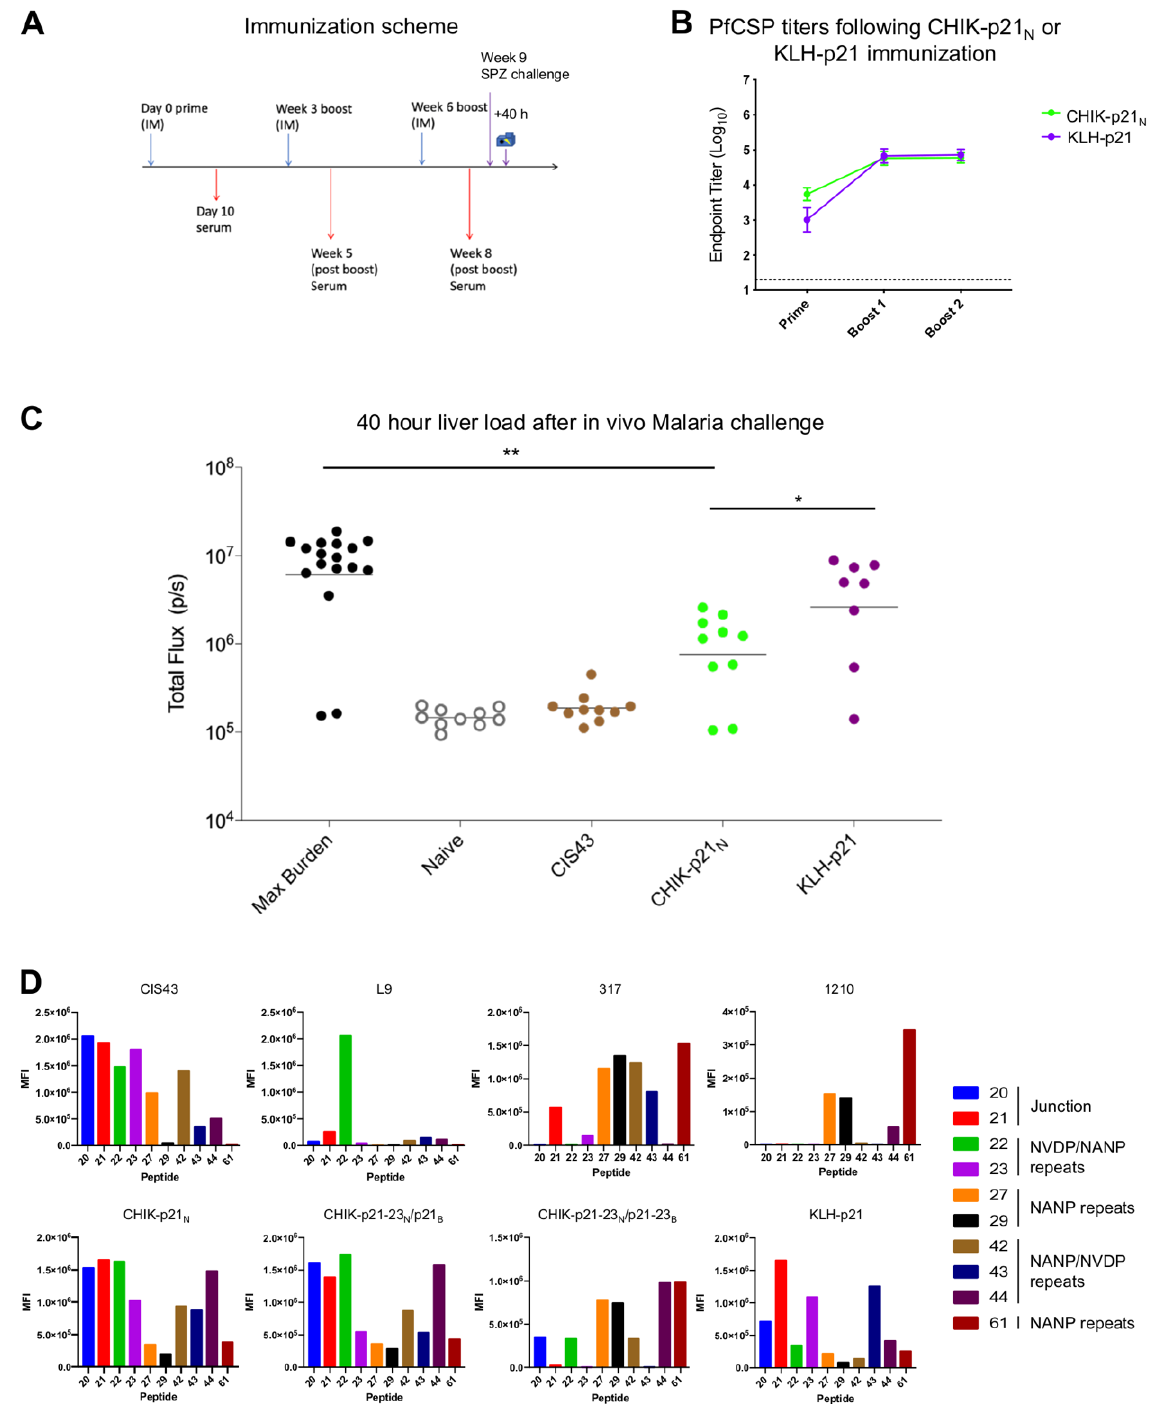
Figure 4. Comparison of malaria protection induced by CHIK-p21 and KLH-p21. ( A ) Immunization and challenge schema. Blue arrows denote immunizations and red arrows denote blood draws. Liver burden was quantified 40 h post challenge. ( B ) Pre-challenge PfCSP ELISA serum titers. ( C ) Liver burden following malaria challenge with Pb-PfCSP-GFP/Luc-SPZ. As a positive control, mAb CIS43 was administered IV prior to challenge. * p < 0.05, ** p < 0.01 as calculated by two-tailed Mann–Whitney test. ( D ) Mapping to overlapping peptides (described in Table S1) by reference monoclonal antibodies (top row) or vaccine serum post-boost (week 8, bottom row). Week 8 sera from experiments described in Figure 3 was used for CHIK-p21 N , CHIK-p21-32N/p21 B , and CHIK-p21-32 N /p21-23 B .